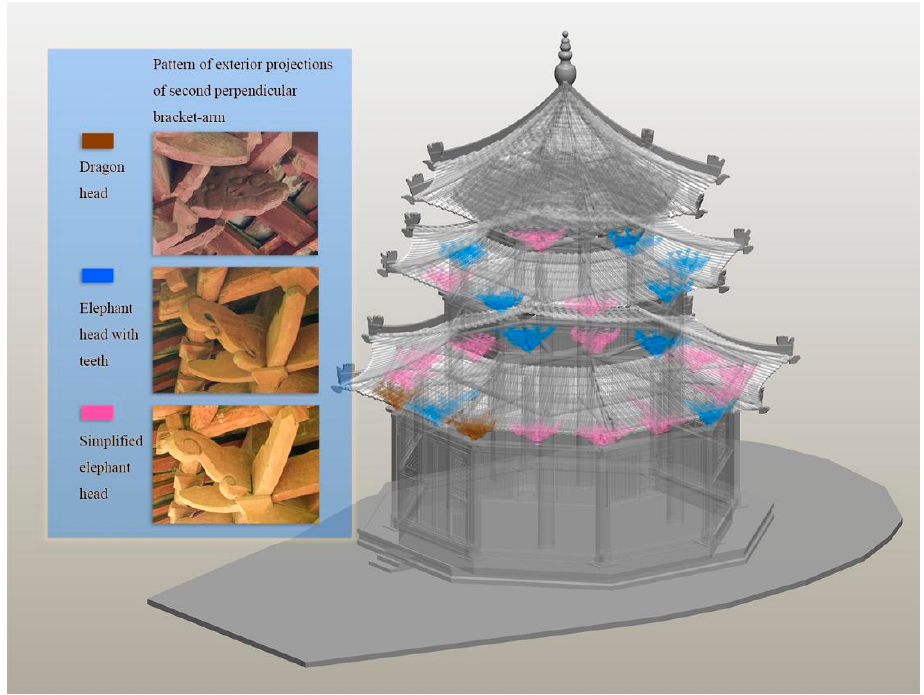
Figure 23. The pattern of exterior projections of the second perpendicular bracket arm.